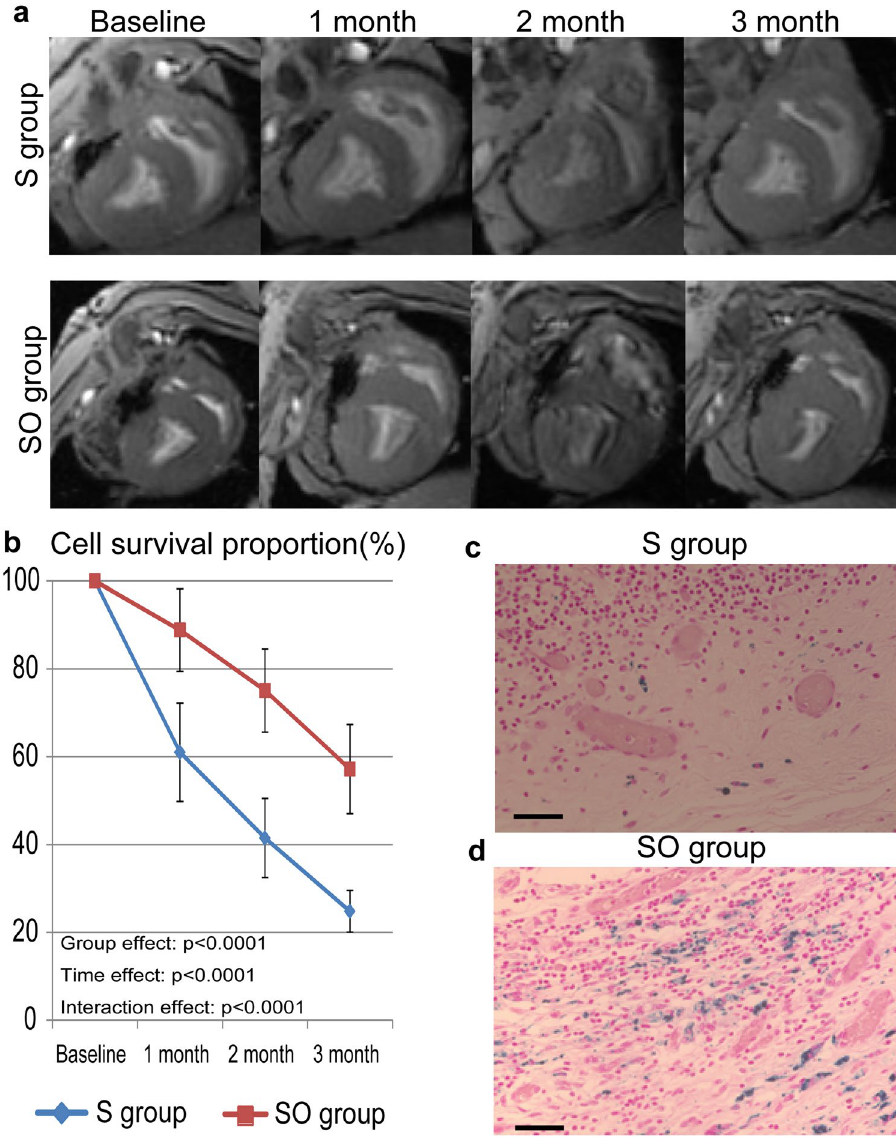
Figure 5. In vivo analysis of the survival of SPIO-labeled hiPS-CMs after transplantation. ( a ) Serial CMRs were examined at 1 week (baseline), 1 month, 2 months, and 3 months after SPIO-labeled hiPS-CM cell-sheet transplantation, with or without the omentum. ( b ) Cell survival proportion was estimated by the SPIO-labeled area at 1 month, 2 months and 3 months, corrected by cell survival at 1 week. ( c , d ) Cells containing iron, indicative of SPIO-labeled hiPS-CMs, were detected by Prussian Blue staining of sections of the S group ( c ) or the SO group ( d ) at the transplanted area; bar = 50 μ m in ( c , d